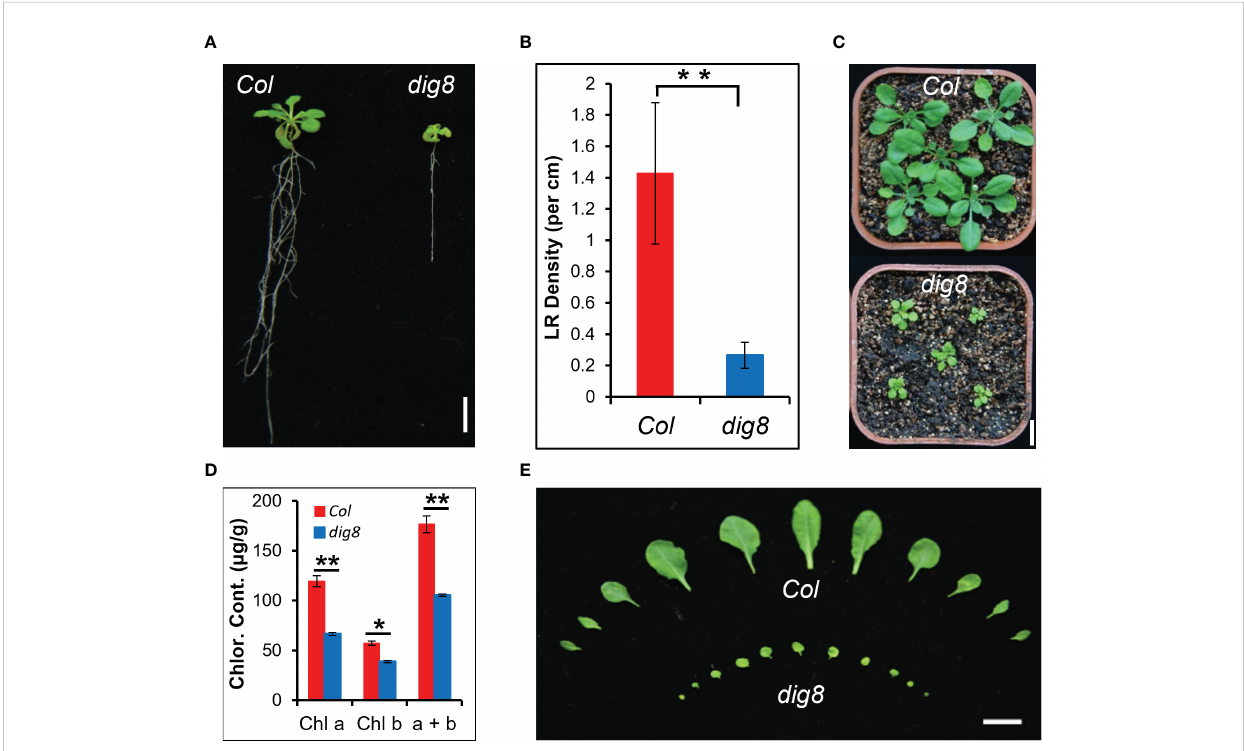
FIGURE 1 Identi fi cation of the dig8 mutant. (A) , The dig8 mutant has fewer lateral roots. Scale bar, 1 cm. (B) , Lateral root (LR) density in the dig8 mutant and Col. Error bars represent SD (n=30). **P < 0.01 (Student ’ s t test). (C) , Morphology of Col and dig8 seedlings in soil. Scale bar, 1 cm. (D) , Chlorophyll contents in Col and dig8 mutant. Shown are means of chlorophyll a, chlorophyll b and their total contents. Error bars represent SD from three replicates. *P < 0.05 and **P < 0.01 (Student ’ s t test). (E) , Comparison of the rosette leaves at transition from the vegetative to the reproductive stage. Scale Bar, 1